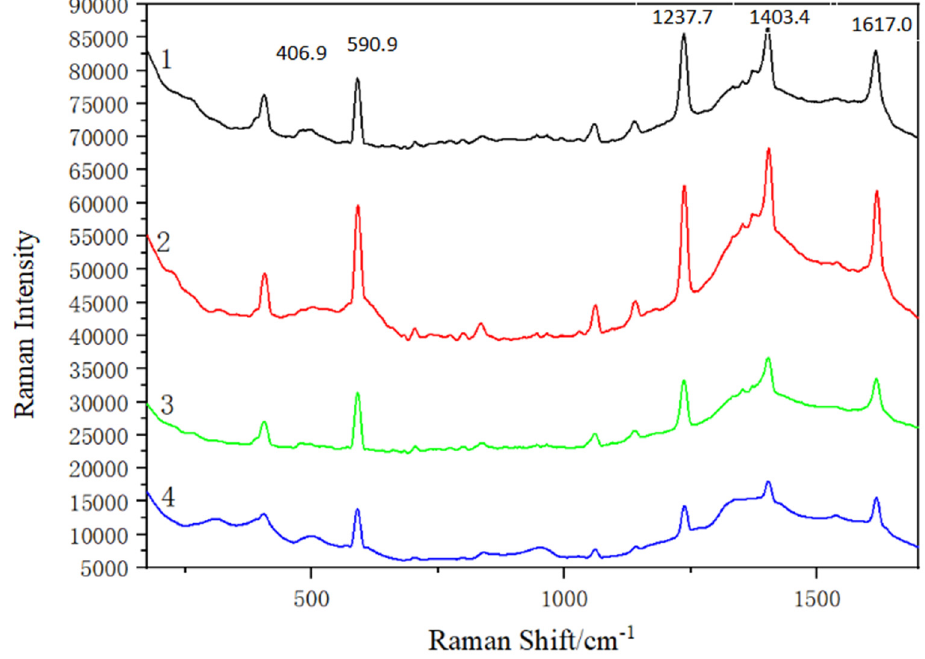
Figure 5. SERS signal of pyrene obtained on Au NPs substrate reduced by different masses of sodium citrate. (1) 0.028g; (2) 0.022g; (3) 0.016g; (4) 0.010g.